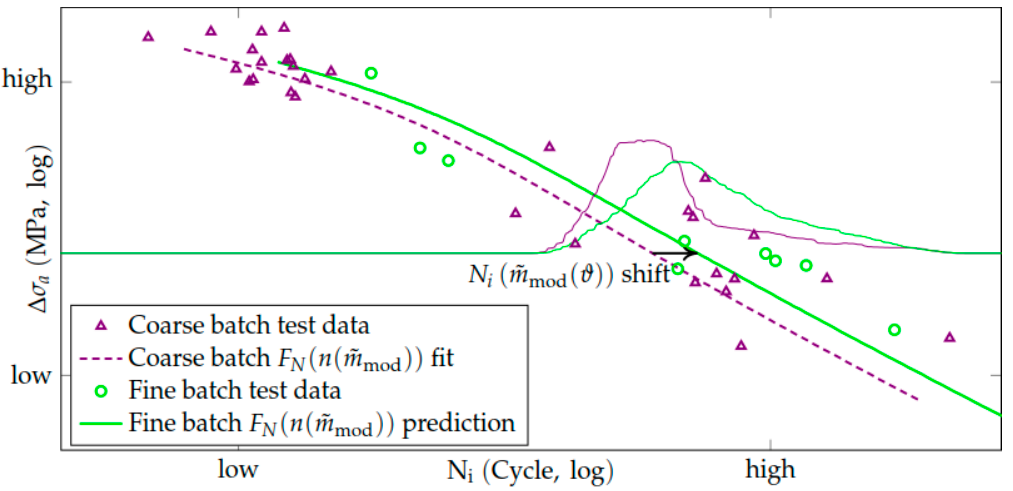
Figure 18. Stress-life plot of test data and fit and prediction curves for the modified Schmid factor distribution model.